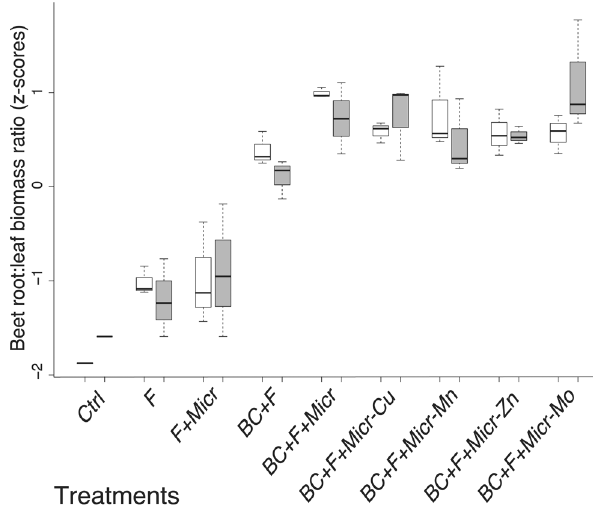
Figure 3: Beet root - to - leaf biomass ratio; data standardized as z - scores, calculated separately for each year: white = 2016 and gray =